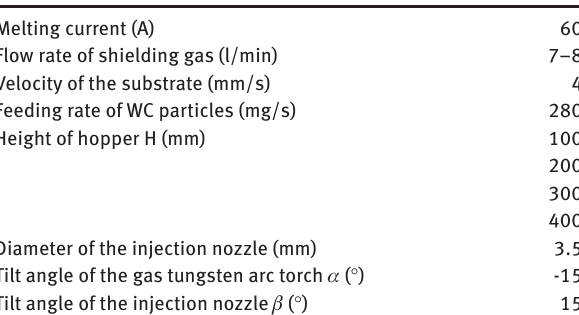
Figure 2: Schematic diagram of the GTAMI system. Table 3: Parameters of the GTAMI